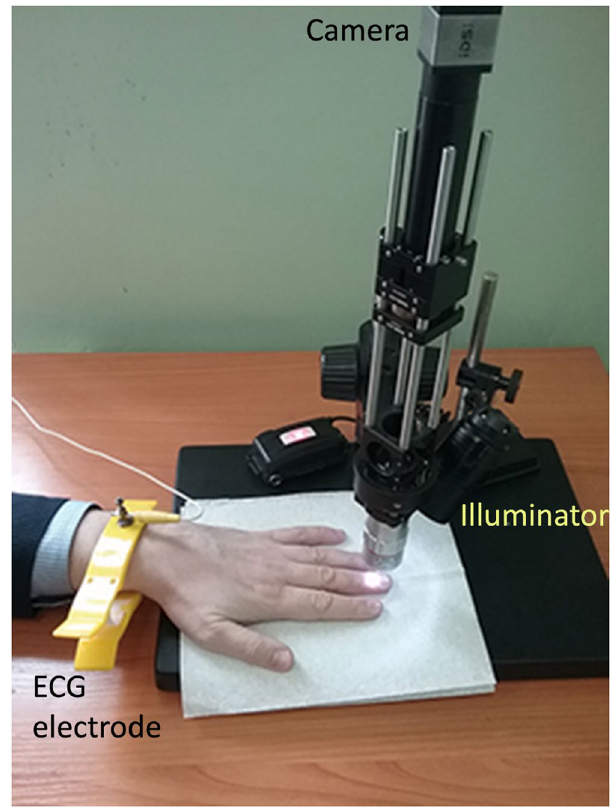
Figure 6. Video capillaroscopy setup for simultaneous recordings of ECG and microscopic video of